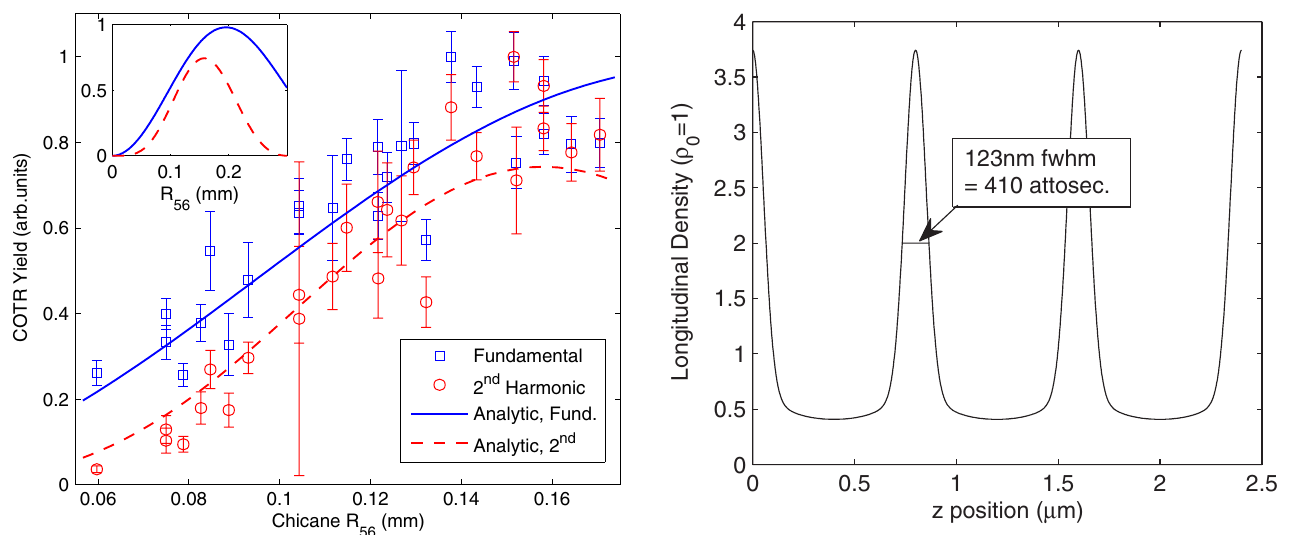
FIG. 5. Longitudinal electron density versus position [Eq. (2)] . The first and second 56 at the center of the electron bunch using the measured experi- (cid:1) 0 : 16 mm , (cid:3) (cid:1) 0 : 5 (cid:12) 140 keV = 60 MeV , mental values: R 56 (cid:1) 17 keV (rms). At the edges of the bunch, both and (cid:5) (cid:2) longitudinally and transversely the laser field is weaker and corresponding microbunch formation weaker.